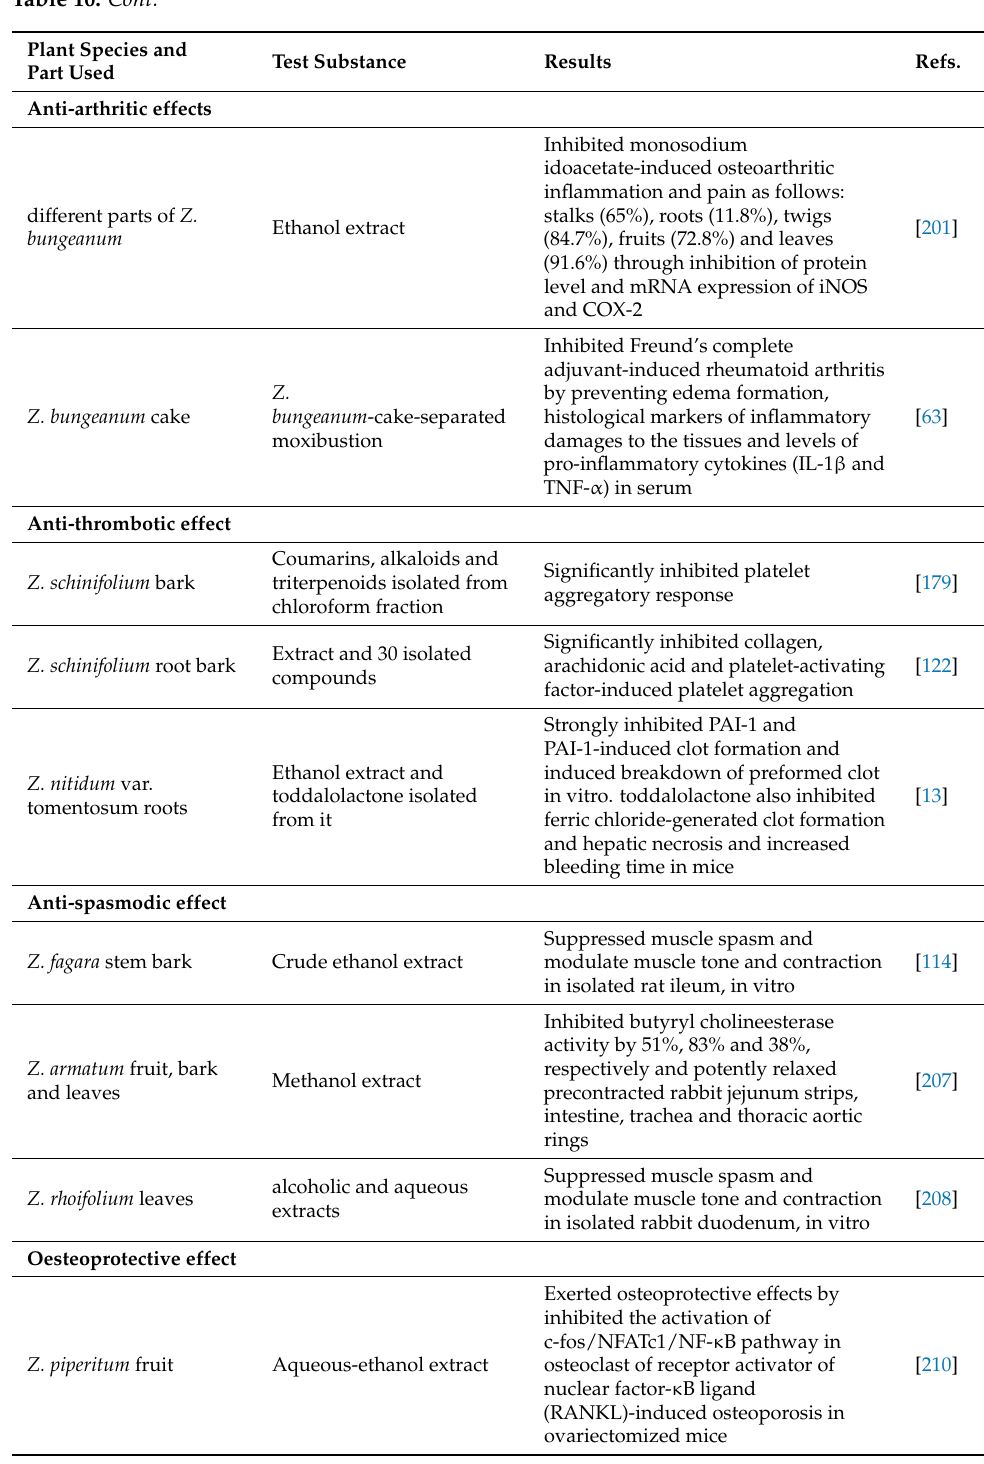
Table 10. Cont. Plant Species and Test Substance Results Part Used